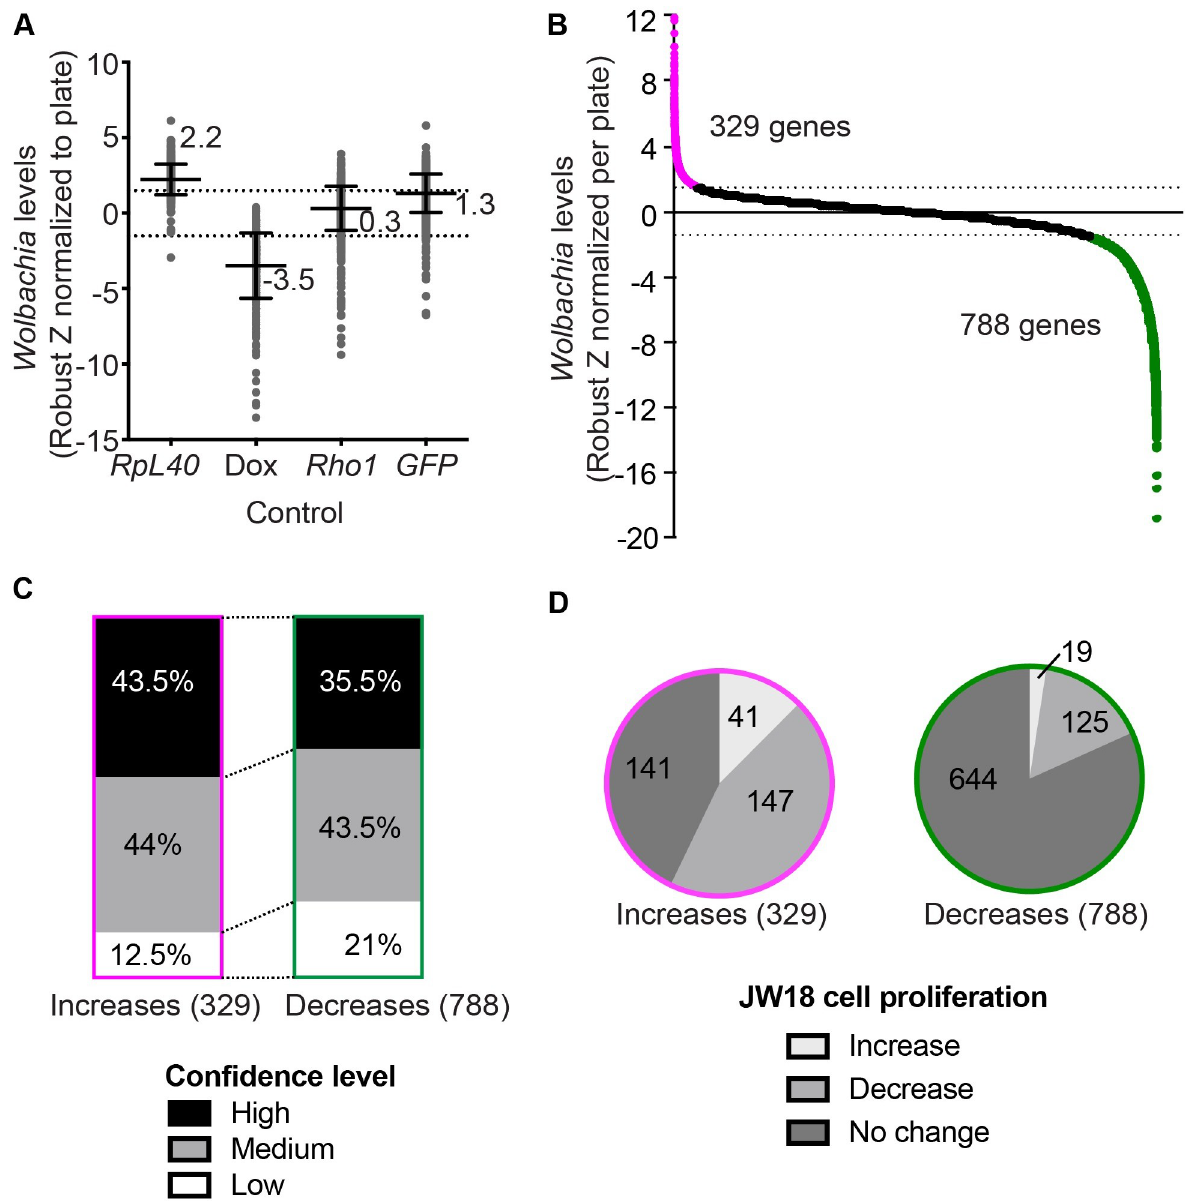
Fig 3. Genome-wide screen controls and primary results. ( A) Plot of screen-wide controls’ effect on Wolbachia levels (Robust Z score normalized for each plate) included RNAi silencing of a host ribosomal gene RpL40 to increase Wolbachia , doxycycline treatment to decrease Wolbachia , RNAi silencing of Rho1 as a negative control, and RNAi silencing of a GFP-Jupiter transgene as a positive control for RNAi in our system that has no effect on Wolbachia levels. Bars represent the median and interquartile range of the robust Z scores for each control in the whole genome screen. ( B) The whole genome screen yielded 1117 primary hits with a robust Z score of � 1.5 or � -1.5. These genes included 329 genes that increase Wolbachia (magenta) and 788 genes that decrease Wolbachia (green) upon RNAi knockdown. ( C) 1117 primary hits categorized according to confidence level (see S4 Fig ). ( D) 1117 primary hits’ effects on JW18 cell proliferation. For the genes that significantly increased Wolbachia levels (magenta), 12% (41 hits) significantly increased cell proliferation (robust Z > 1), 43% (141 hits) did not have a significant effect on cell proliferation, and 45% (147 hits) resulted in significant decreases in cell proliferation (robust Z < -1). For genes that significantly decreased Wolbachia levels (green), 2.4% (19 hits) significantly increased cell proliferation (robust Z > 1), 82% (644 hits) did not have a significant effect on cell proliferation, and 16% (125 hits) significantly decreased cell proliferation (robust Z < -1). See S4–S6 Figs for screening pipeline and further results analysis, S9 Fig for whole genome cell proliferation analysis, and S5 and S6 Tables for selection of amplicons and complete listing of genes.